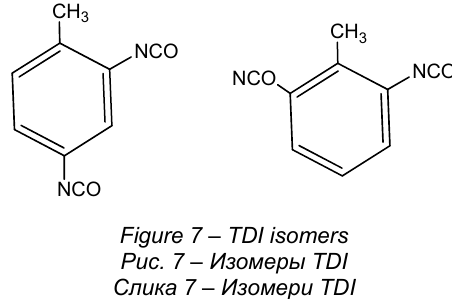
Figure 7 – TDI isomers Рис . 7 – Изомеры TDI Слика 7 – Изомери